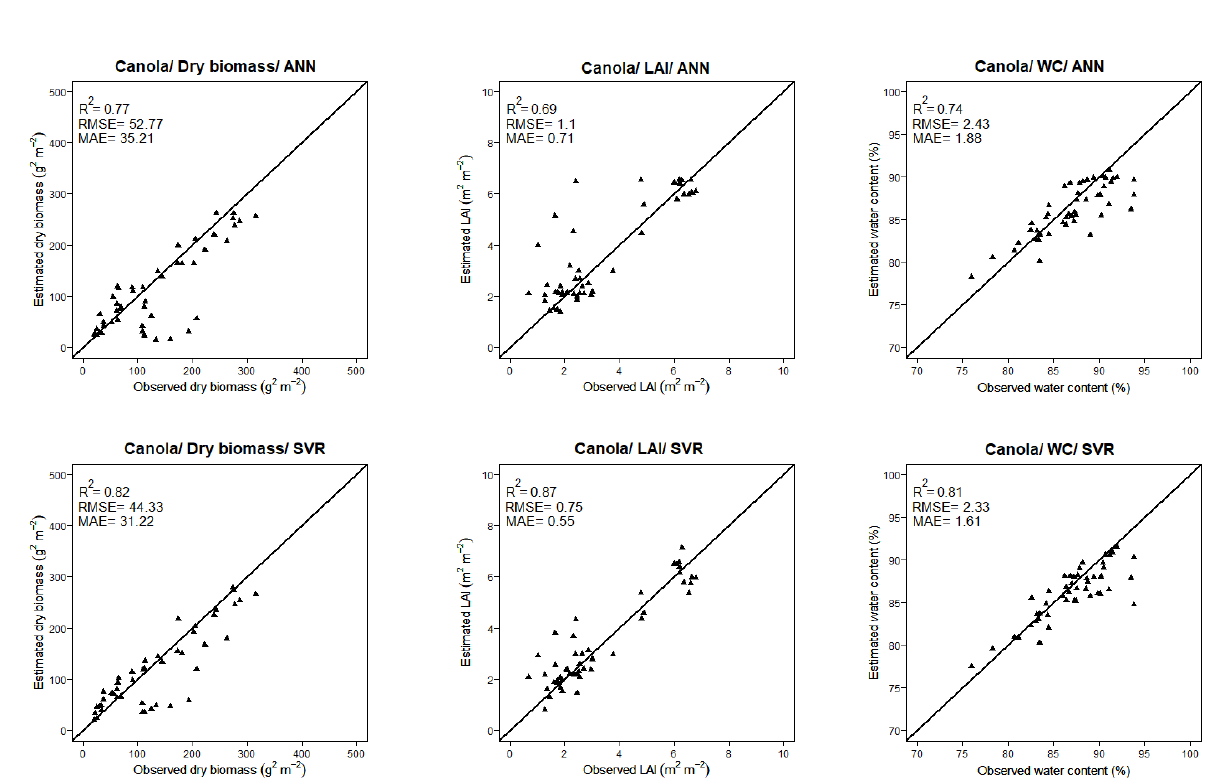
Figure 2. One-to-one relationships between predicted and measured crop parameters; modelling by ANN and